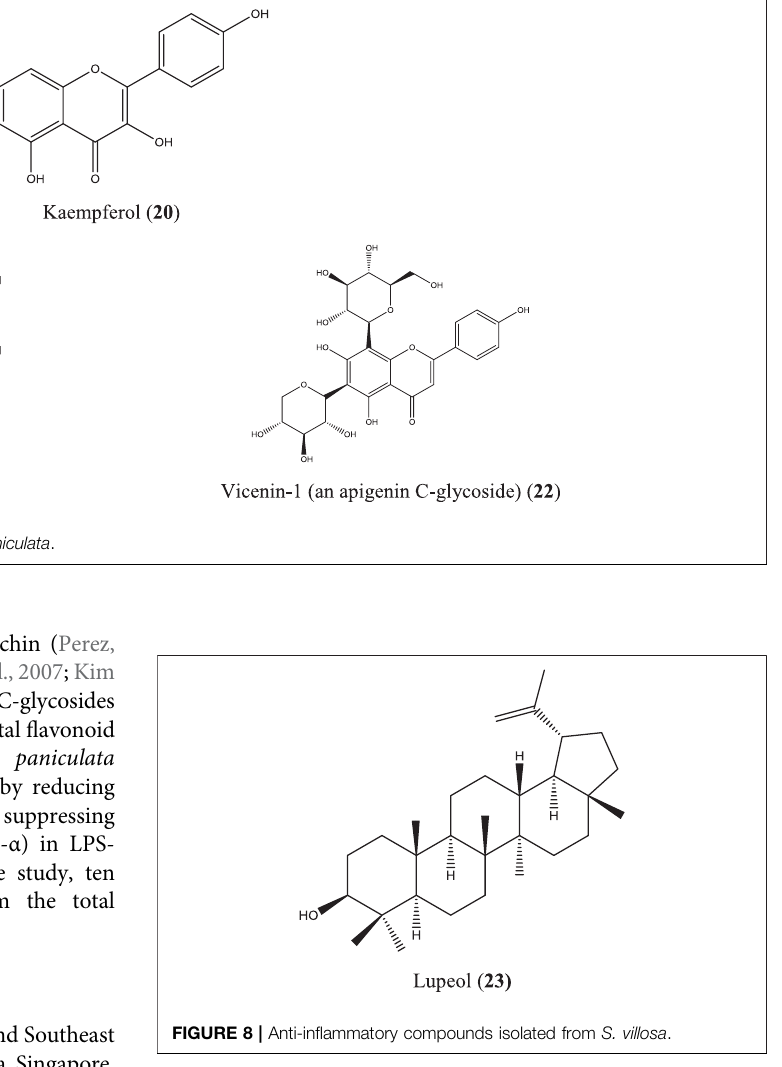
FIGURE 8 | Anti-in fl ammatory compounds isolated from S. villosa